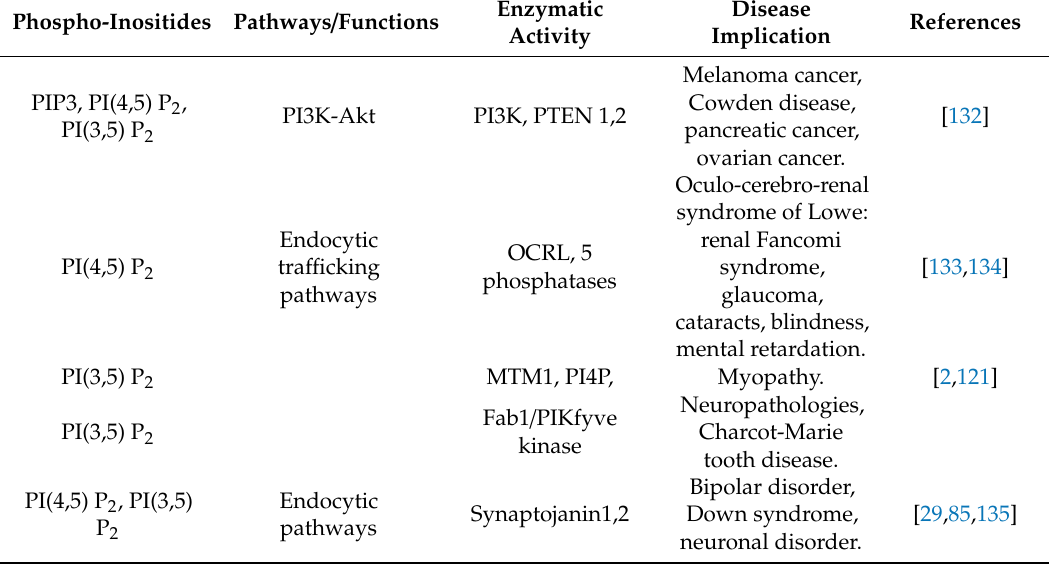
Table 1. PIP 2 and enzymatic activity in di ff erent pathways in disease